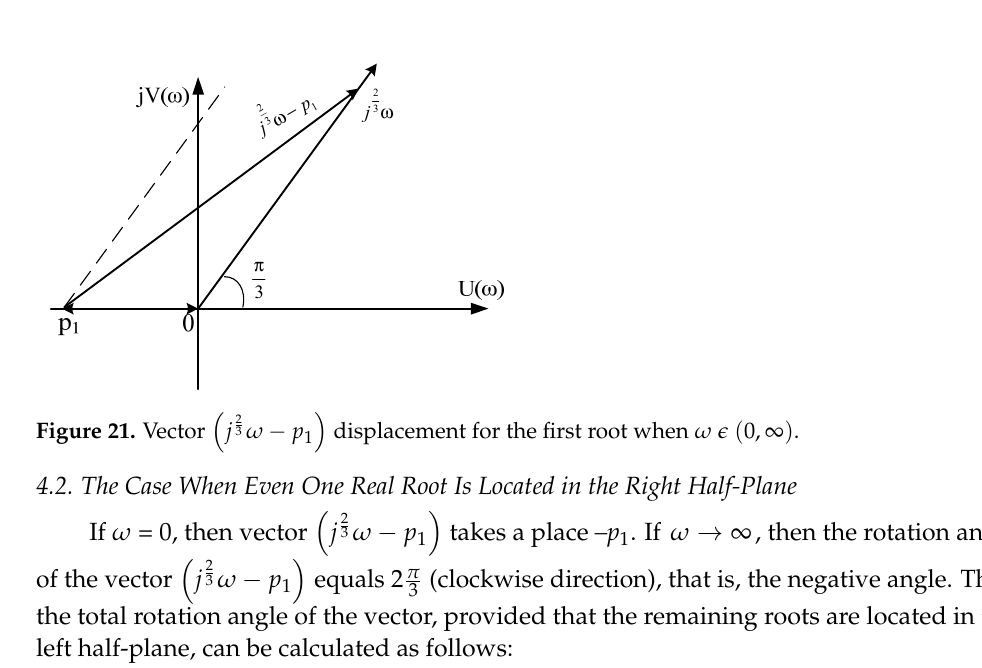
(cid:3118) Figure 21. Vector (𝑗 (cid:3119) 𝜔 − 𝑝 (cid:2869) ) displacement for the first root when 𝜔 𝜖 (0,∞) .